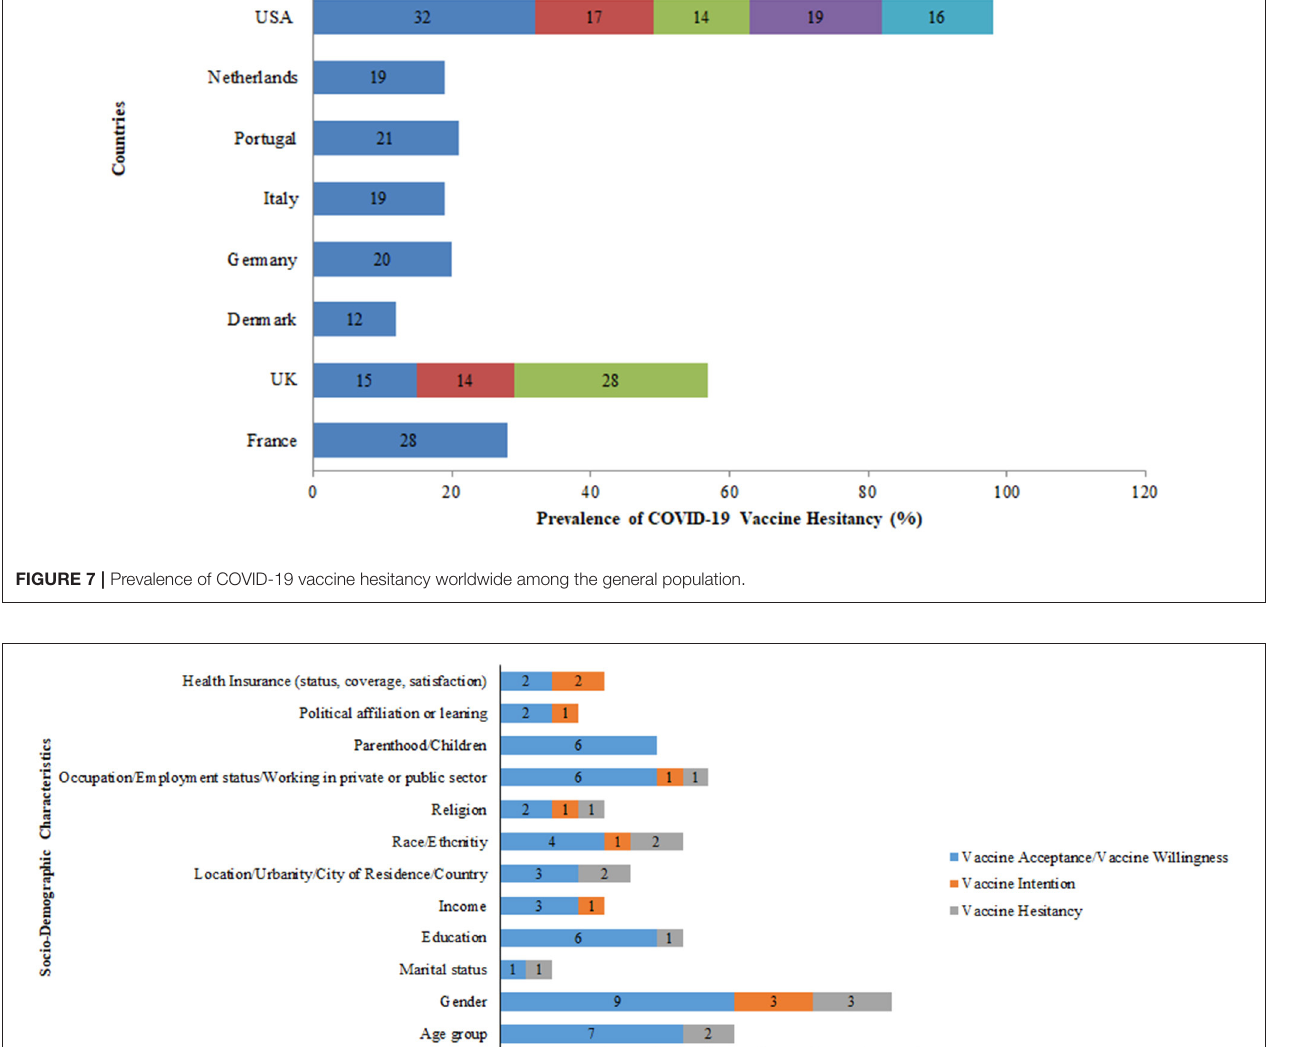
race, a higher level of perceived potential vaccine harms, unemployment, and not having received the influenza vaccine in the prior year. Few concerns regarding the COVID-19 vaccine seen across the globe were suspicions regarding vaccine safety, potential side effects, efficacy, and rapid development of the COVID-19